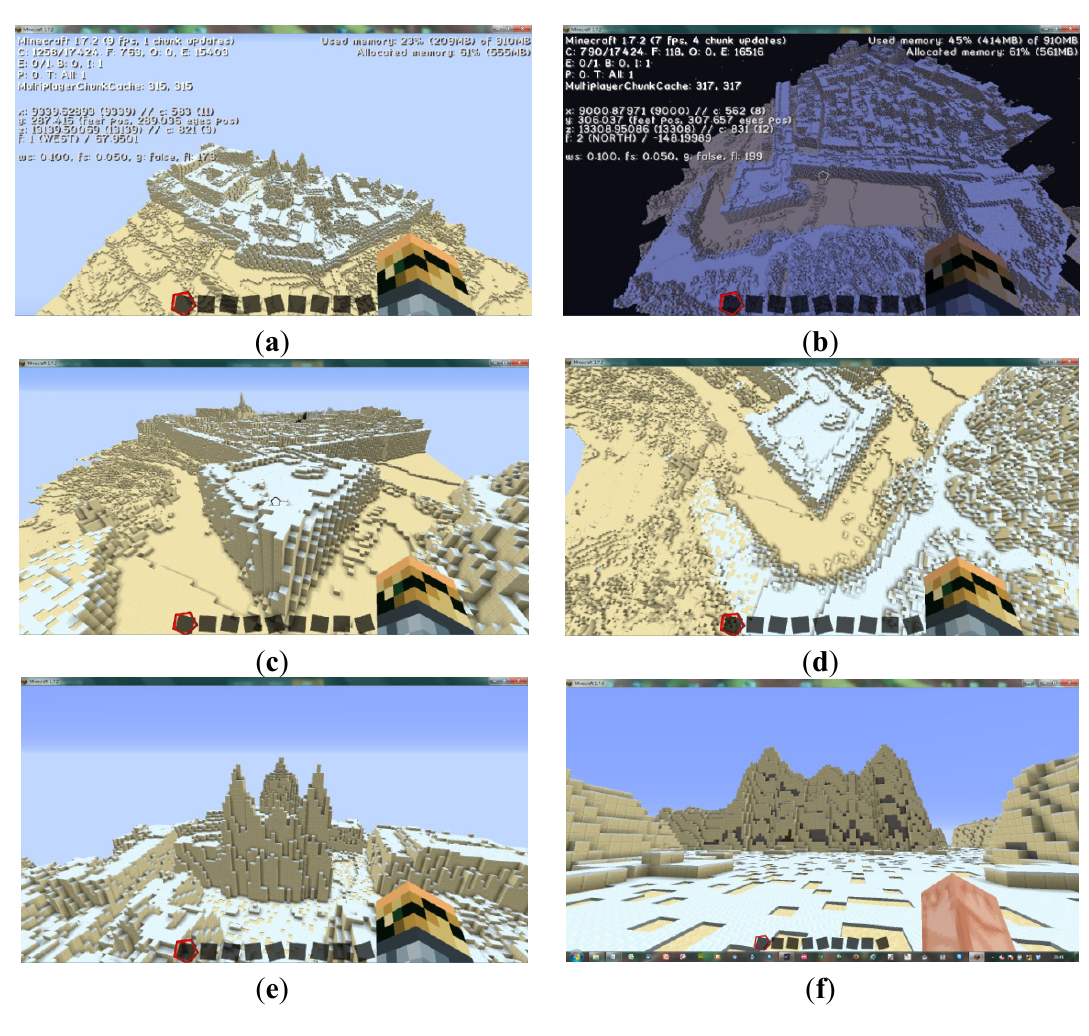
Figure 3. Minecraft virtual space engine results for the walled citadel of Mdina ( a ) coordinate analysis-Day-time simulation; ( b ) coordinate analysis-Night-time simulation; ( c ) 1 m block conversion output–side perspective; ( d ) 1 m block conversion output–top perspective; ( e ) main square aerial view; ( f ) main square walkabout